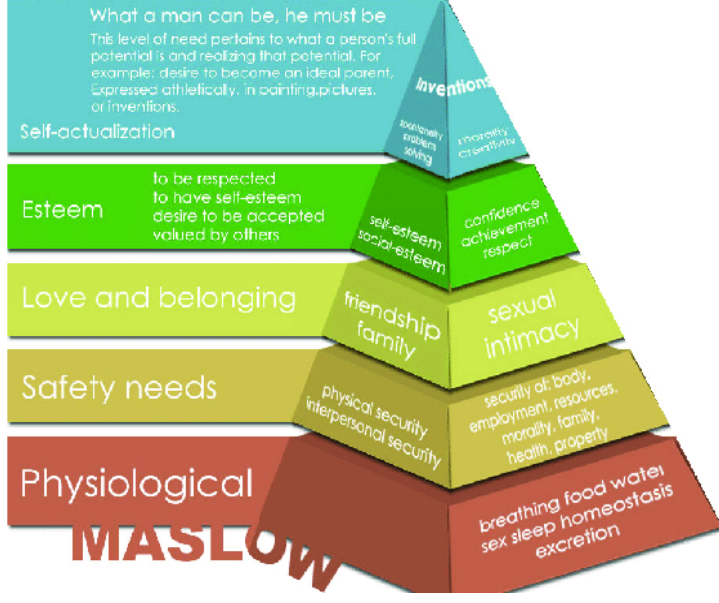
Figure 1: Maslow’s hierarchy of needs (Maslow’s pyramid) [12,